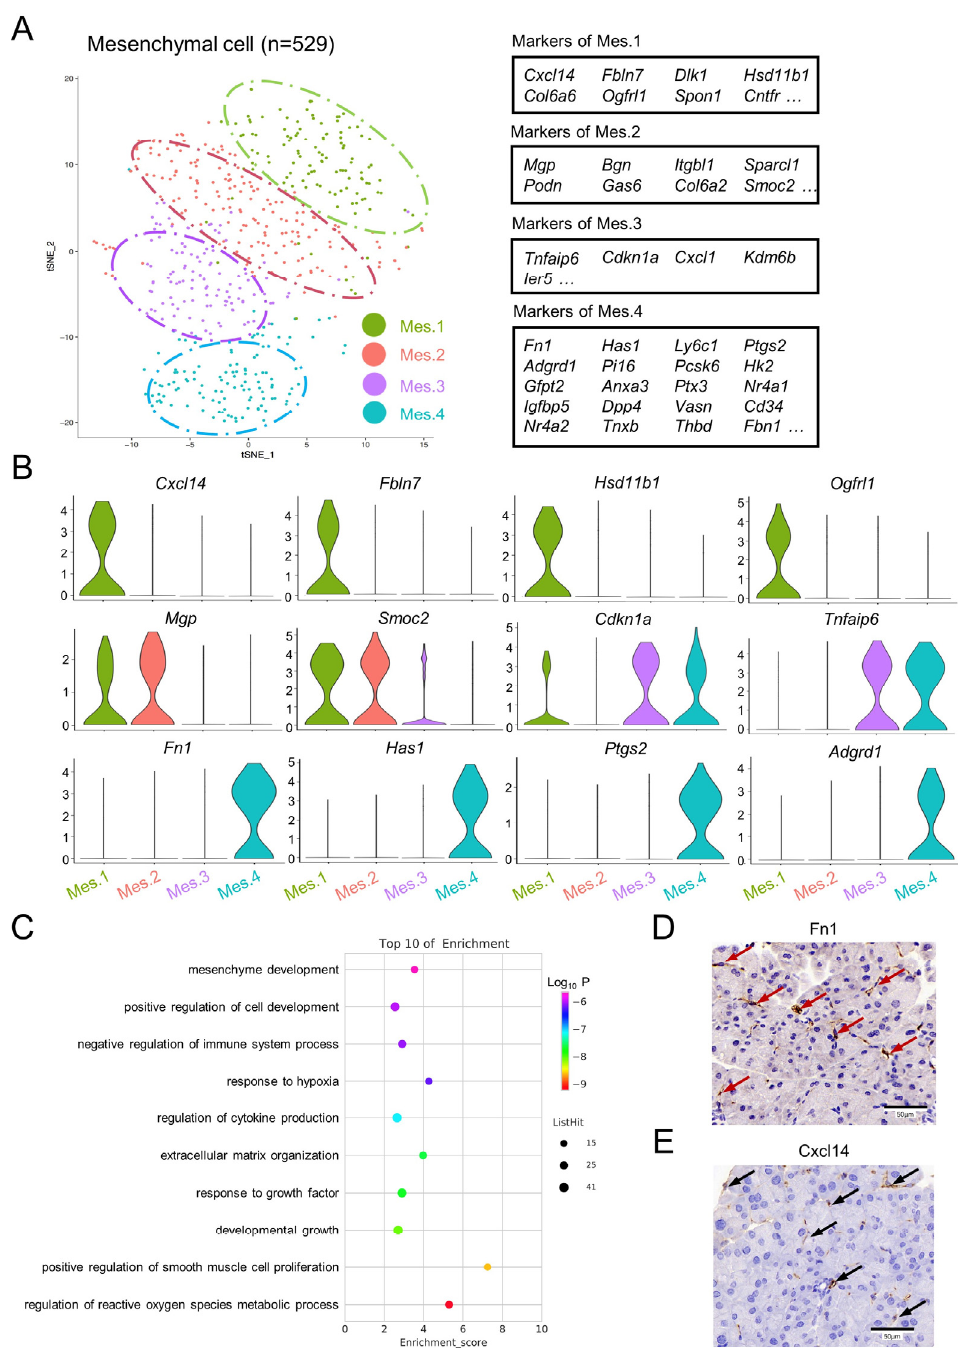
Figure 3. Subpopulation identification of pancreatic mesenchymal cells in normal mice. ( A ) t-SNE illustration of four subgroups identified from sub-clustering of the mesenchymal cell population, colored according to the cluster assignments (left panel). Tables demonstrating the top differentially expressed genes when comparing one subcluster to all other mesenchymal cells (right panel). ( B ) Violin plots showing representative marker genes in the subgroups. ( C ) Representative GO terms enriched for marker genes in Mes.4 based on a functional enrichment analysis. ( D , E ) Representative immunohistochemical images of pancreatic tissues from the control mice stained for Fn1 (red arrow) and Cxcl14 (black arrow). Scale bar = 50 µ